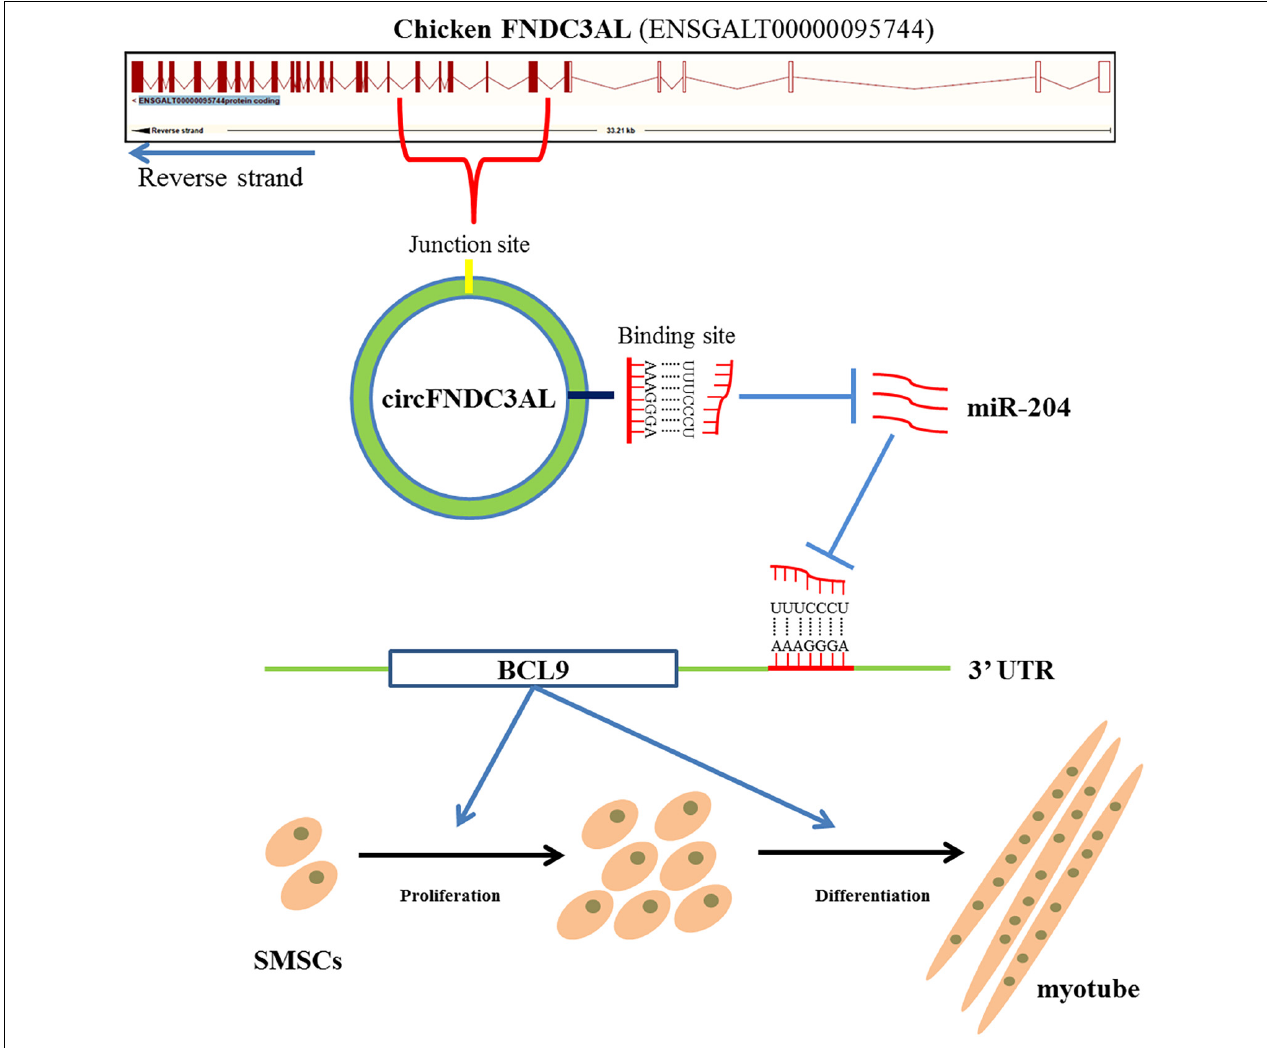
FIGURE 9 | Mechanism of circFNDC3AL regulates chicken SMSC proliferation and differentiation. CircFNDC3AL promotes the proliferation and differentiation of chicken SMSC by up-regulating the expression of BCL9 via binding